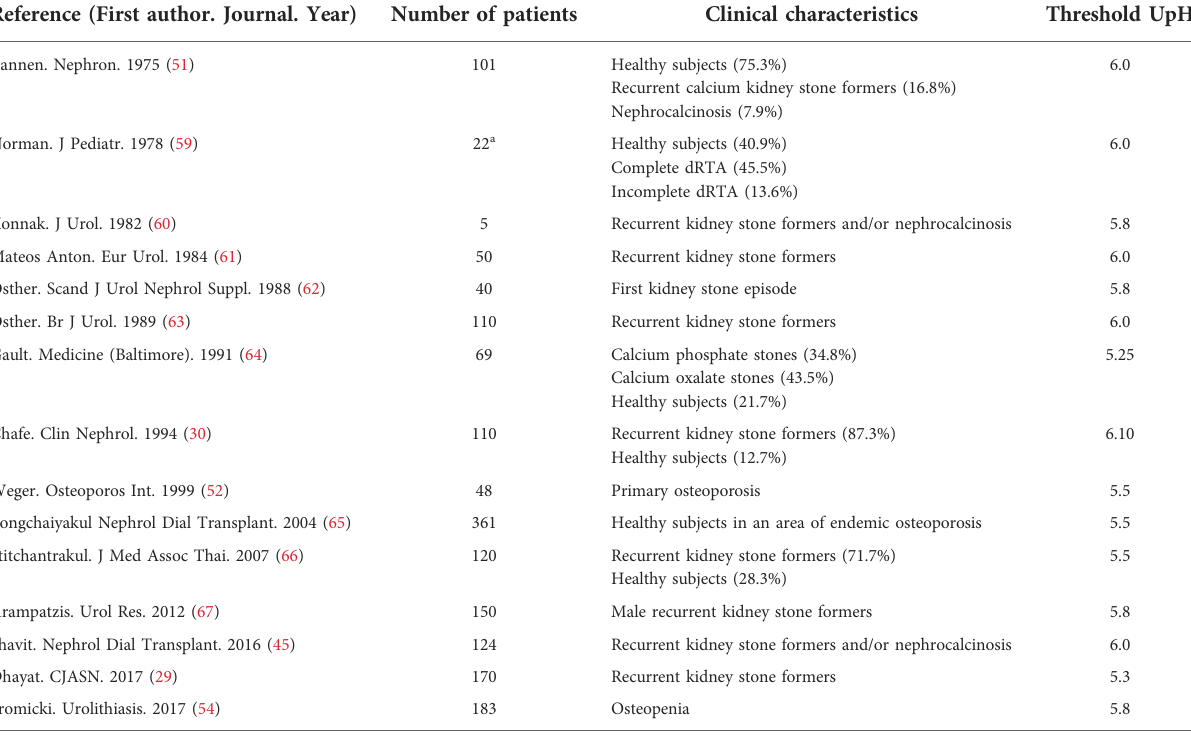
TABLE 1 Studies that analyze single spot urine pH (UpH) in the context of incomplete dRTA